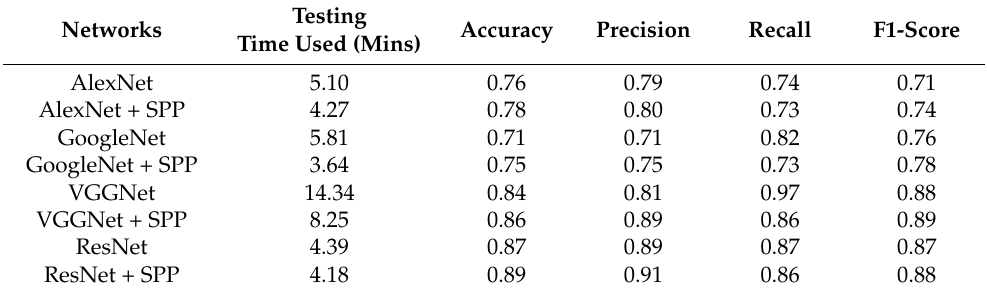
Table 2. The comparison of evaluation indicators on classic network